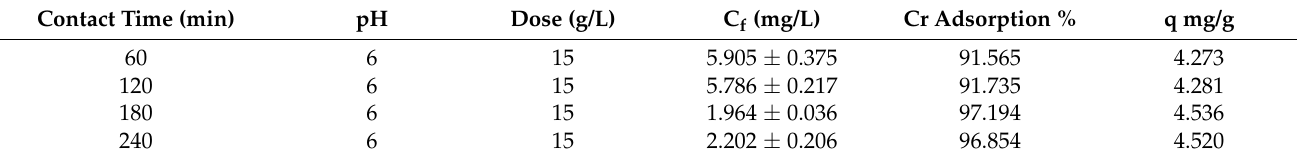
Table 2. Effect of contact time on Pb 2+ removal efficiency (C o = 70 mg/L, agitation speed = 150 rpm). Contact Time